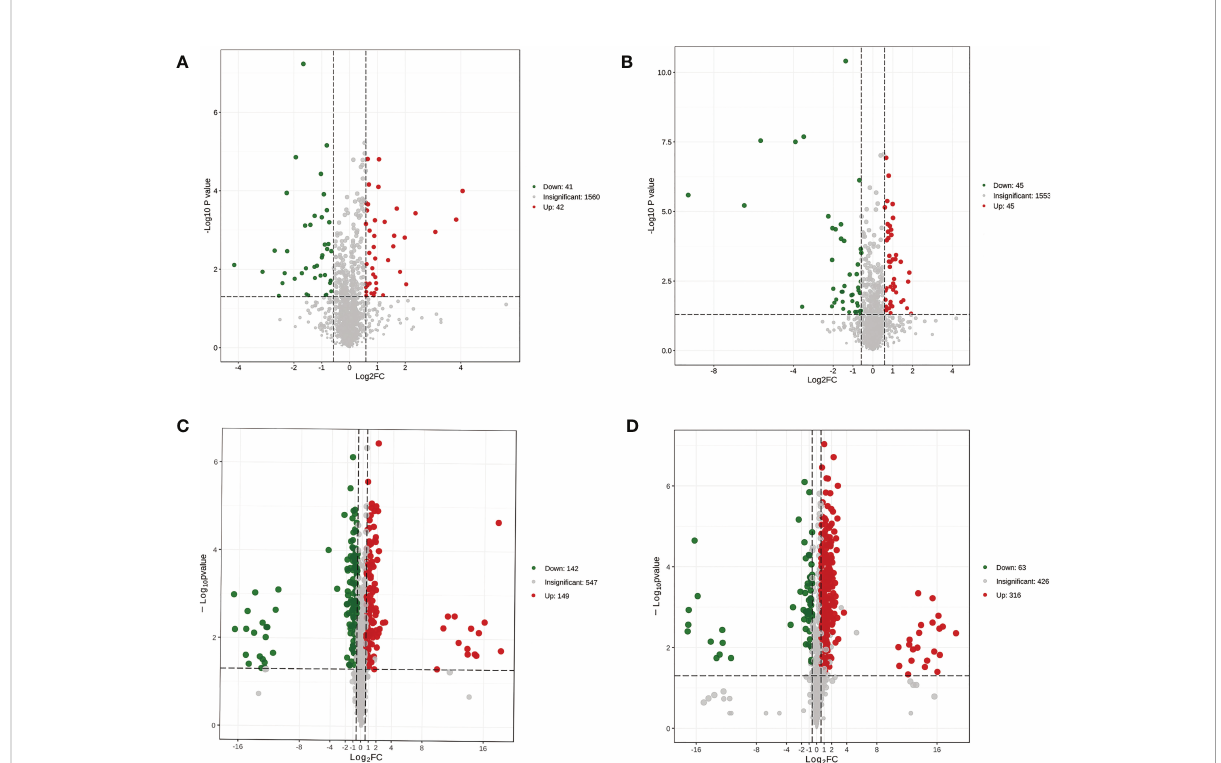
FIGURE 4 Volcano plot of differential metabolites in the pairwise comparison between. (A) MP-S vs. IP-S comparison; (B) MS-S vs. IS-S comparison; (C) MP-R vs. IP-R comparison; (D) MS-R vs. IS-R comparison. Both sides of two dashed vertical lines indicate that the metabolite is down-regulated by less than 1.5 or up-regulated by more than 1.5. Panel (A, B) were plotted based on the mean of six replicates, and panel (C, D) are plotted based on the mean of three